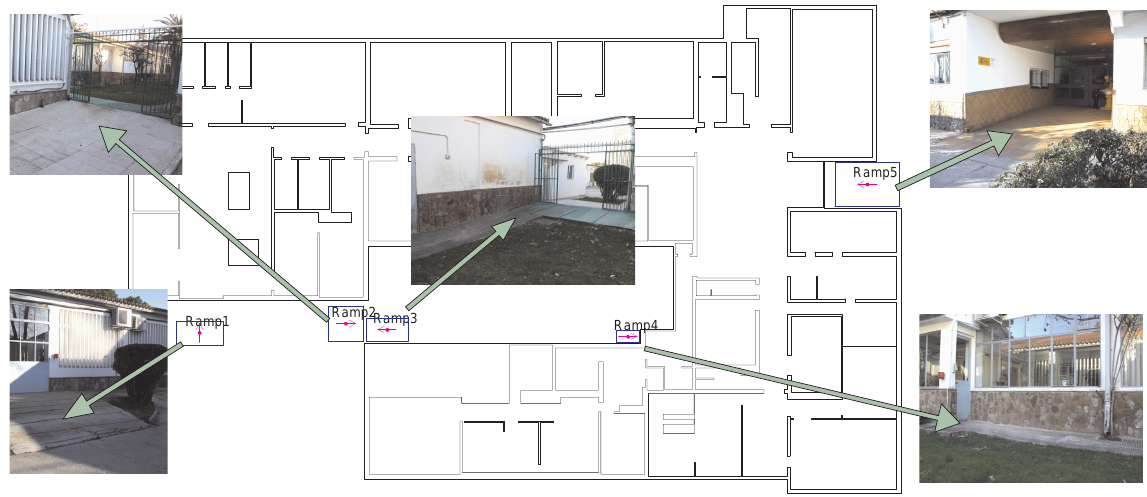
Figure 3. Ramps to access the main building of CAR-CSIC